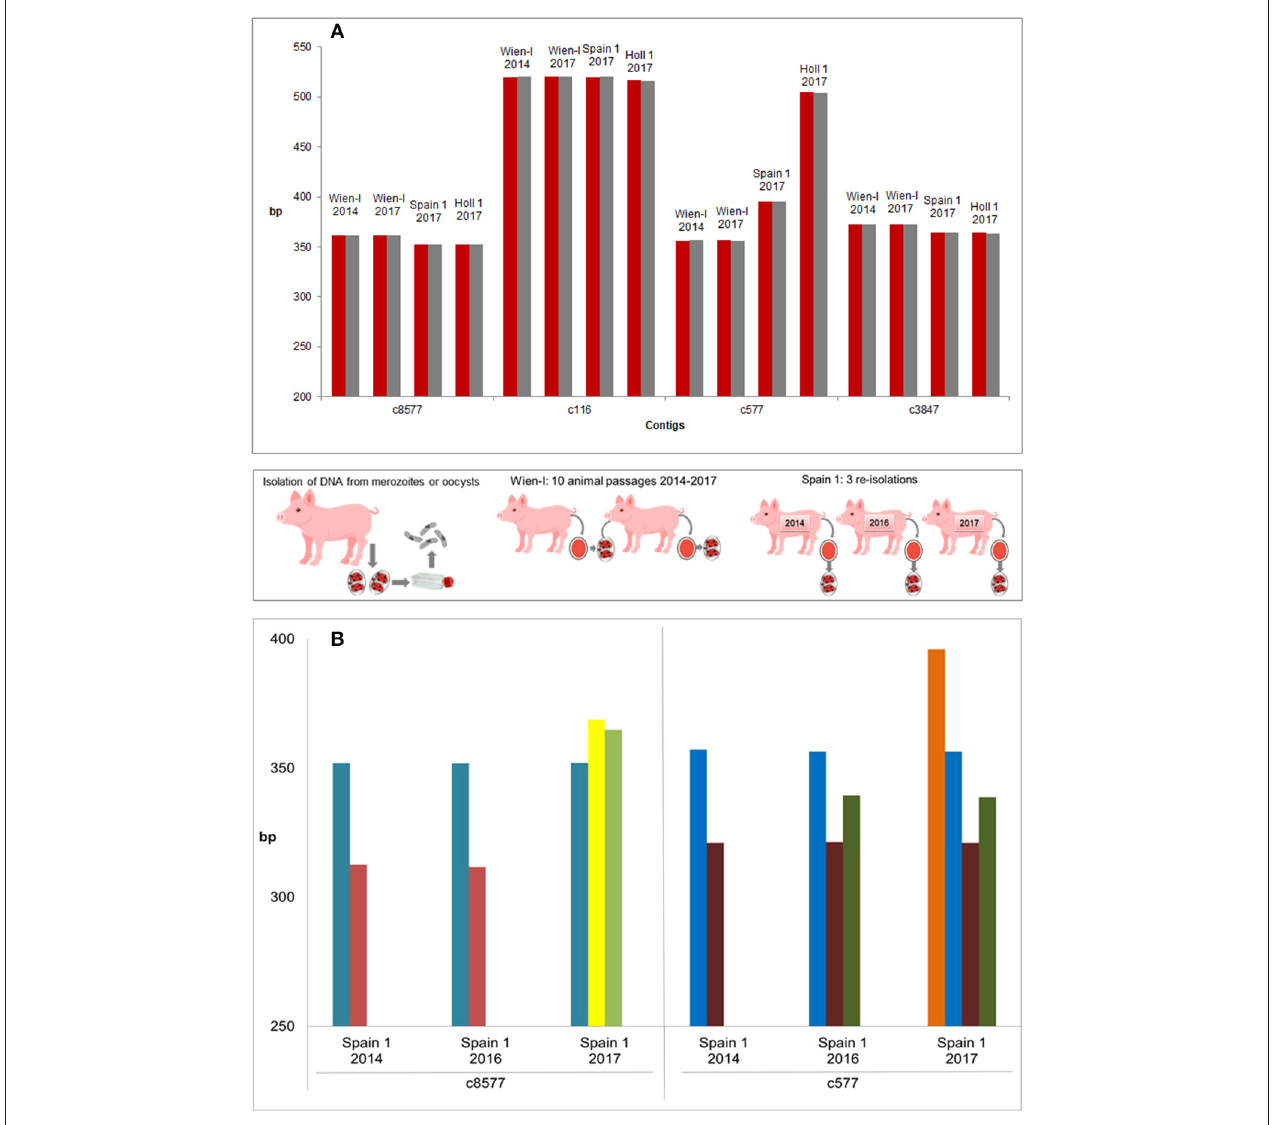
FIGURE 4 | Evaluation of genetic stability and variability of strains and isolates. (A) Genetic stability of different stages and passages within the same strain (three strains incl. Wien I with 10 passages difference). All strains included in this experiment showed the same amplicon length for different stages (oocysts: red, merozoites: gray). No differences could be detected with the used primer pairs by FLA. (B) Genetic variability of three re-isolates of a field strain, Spain 1. PCR products of three independent isolations showed high variations on contigs c8577 and c577 and a clear shift of band pattern from the first (2014) to the third (2017) isolation (bands of the same length in the same color). Middle panel: